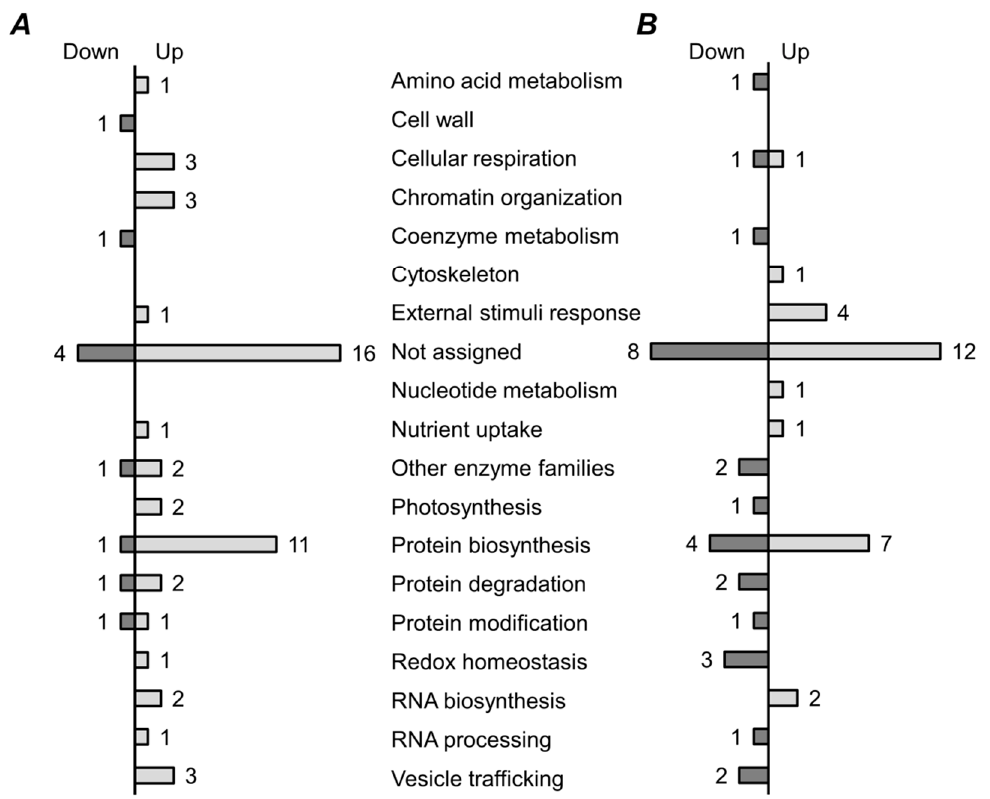
Figure 4. Functional annotation of proteins, di ff erentially regulated in seeds of pea ( P. sativum L) lines K-8274 ( A ) and K-3358 ( B ), characterized with high and low EIBSM, respectively. Functional annotation relied on Mercator tool [35].